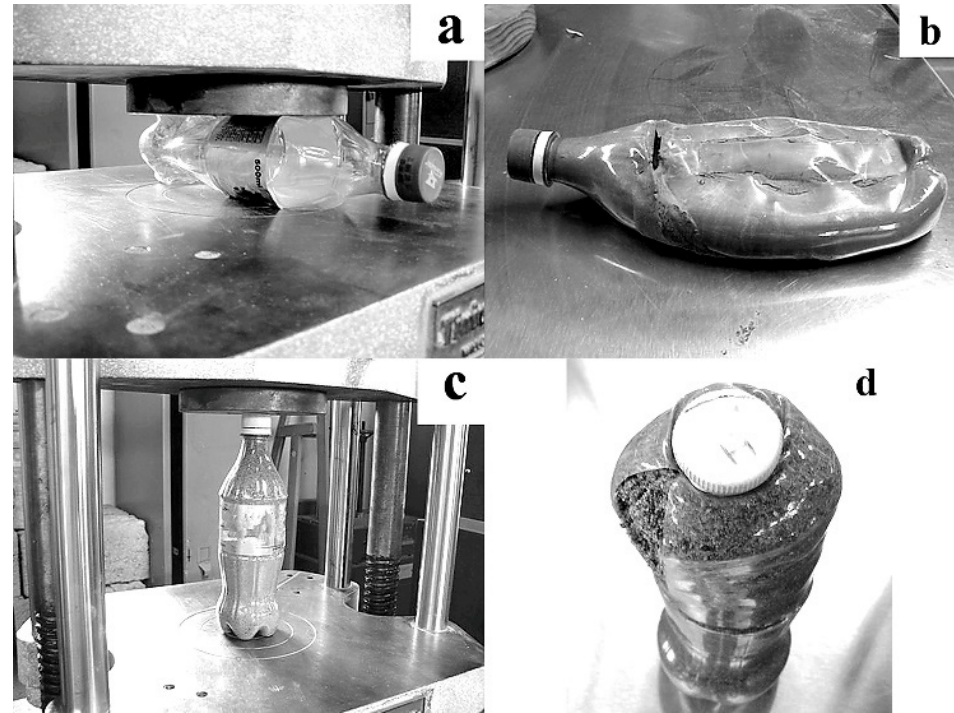
Figure 1. General display of compression tests and occurrence of common fractures: ( a ) Horizontal position for a bottle sealed with air; ( b ) fly-ash-filled bottle tested in the horizontal position; ( c ) sand- filled upright bottle; ( d ) typical fracture in a sand/water-filled upright bottle.